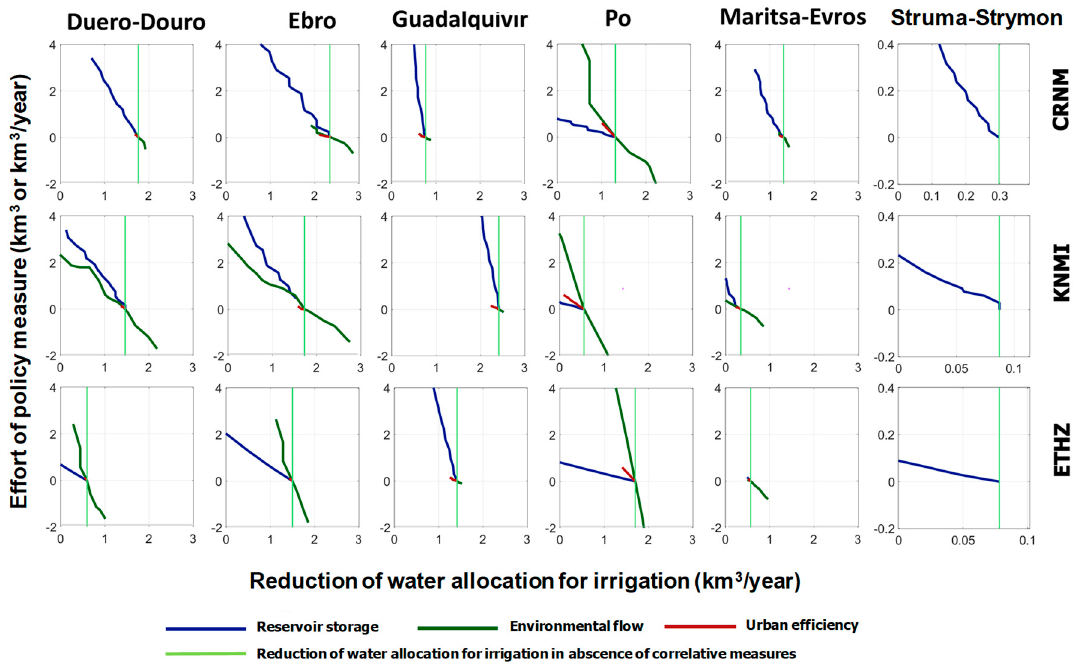
Figure 11. Compared range and effectiveness of the three correlative policies analyzed for the six basins: increased storage (blue), reduction of environmental flow allocation (green), and increased efficiency in urban supply (red). Required adaptation effort in the absence of correlative measures is marked by the vertical light green line. Results for the CRNM ( top ), KNMI ( center ), and ETHZ ( bottom ) models in the long-term time horizon (2070–2100) under emission scenario A1B.